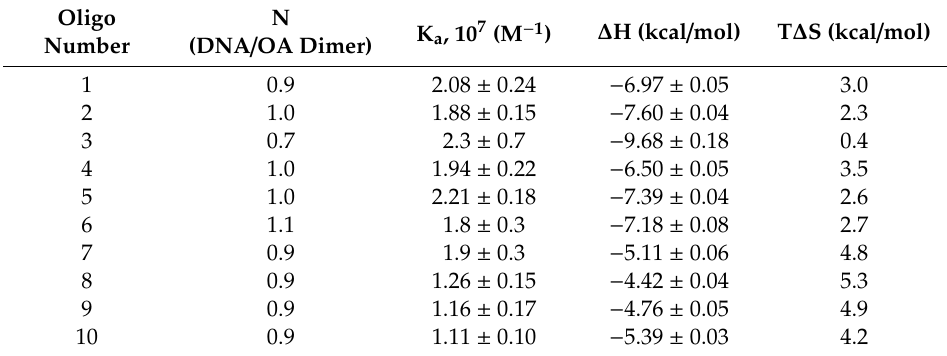
Table 1. Thermodynamic parameters of OA binding to G/C sites obtained by isothermal titration calorimetry (ITC) at 25 °C. Oligo numbering is according to Figure 1B.